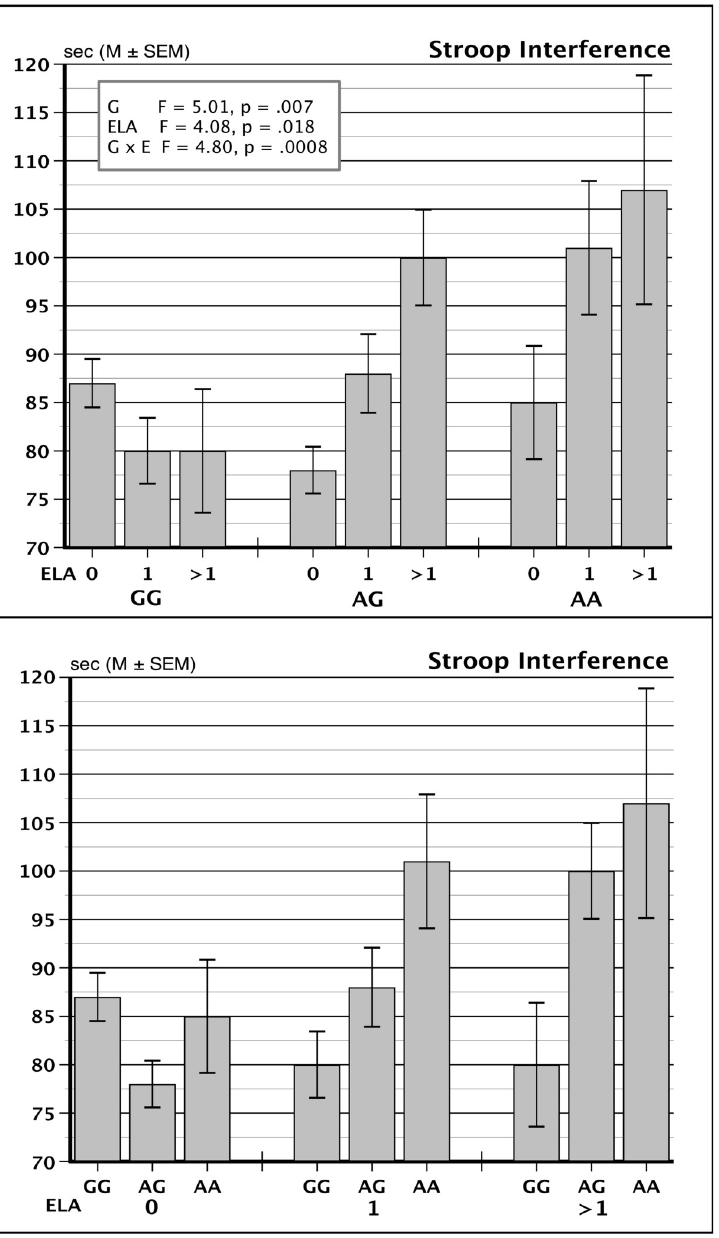
Fig 2. Stroop task interference scores for persons carrying GG, AG and AA genotypes of FKBP5 (rs9196158). Top panel shows results for 0, 1, or > 1 ELA groups within each of the genotypes. Bottom panel shows results for the GG, AG and AA genotypes within each of the ELA